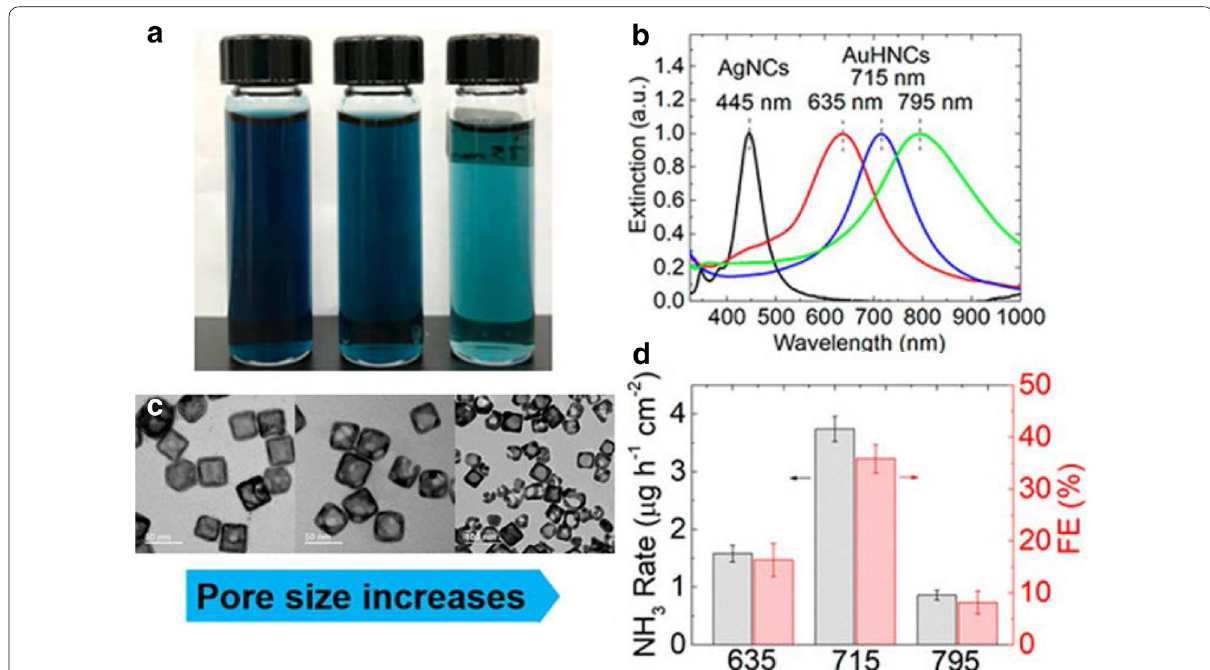
Fig. 8 a AUHNCs dispersed in DI water. b UV–vis spectra of AgNCs and AuHNCs with various peak LSPR values. c TEM images displaying AuHNCs with peak LSPR at 635, 715 and 795 nm. d NH 3 yield rate and Faradaic efficiency for the various LSPR peak values at permission [37] Copyright 2018, American Chemical Society )